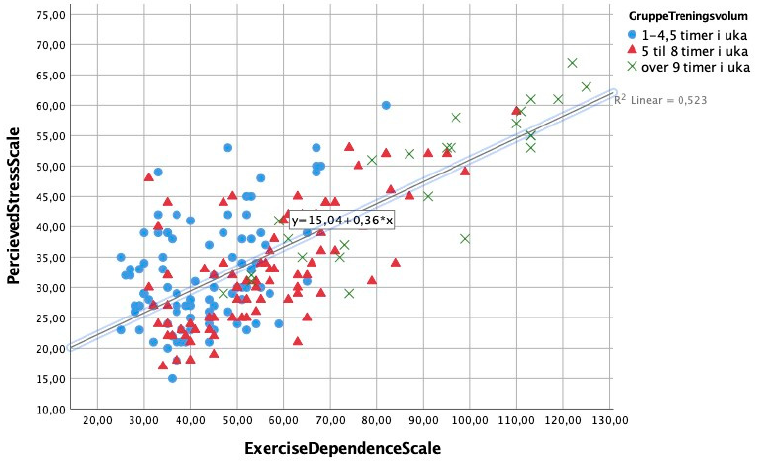
Figure 2. Graphic representation of the association between stress (PSS-score) and exercise-dependence symptoms, by three different levels of weekly exercise hours. Table 2. Correlation analyses.